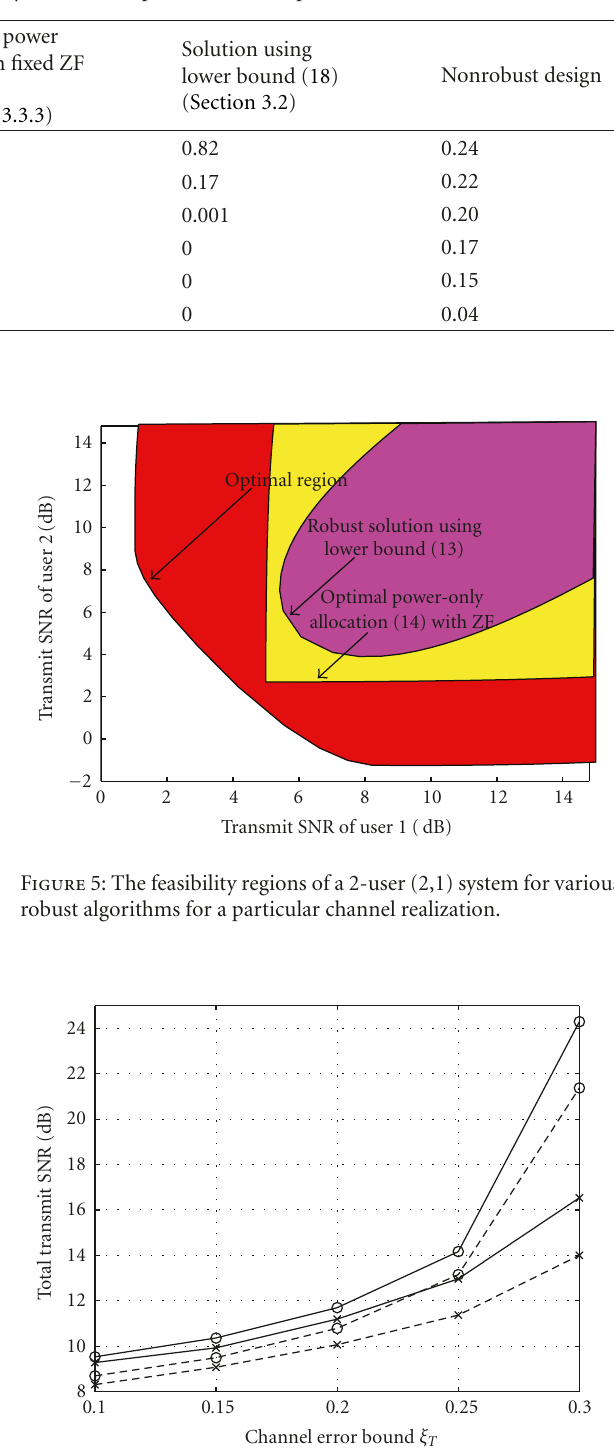
Table 1: Service probabilities for a 2-user (2,1) system with imperfect CSIT but perfect CSIR.